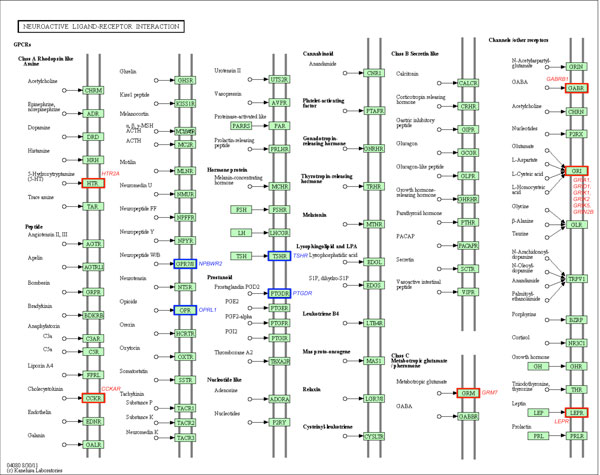
The iLOCi detected genes from BD and their maps in 'neuroactive ligand-receptor interaction' pathway. The KEGG pathway diagram [34] shows the mapping of BD-associated genes identified among 1000 top ranked iLOCi pairs in 'neuroactive ligand-receptor interaction' KEGG pathway. The gene families containing the genes previously reported in HuGE Navigator database and the novel disease genes are highlighted in the red boxes and the blue boxes, respectively, with their associated gene names.